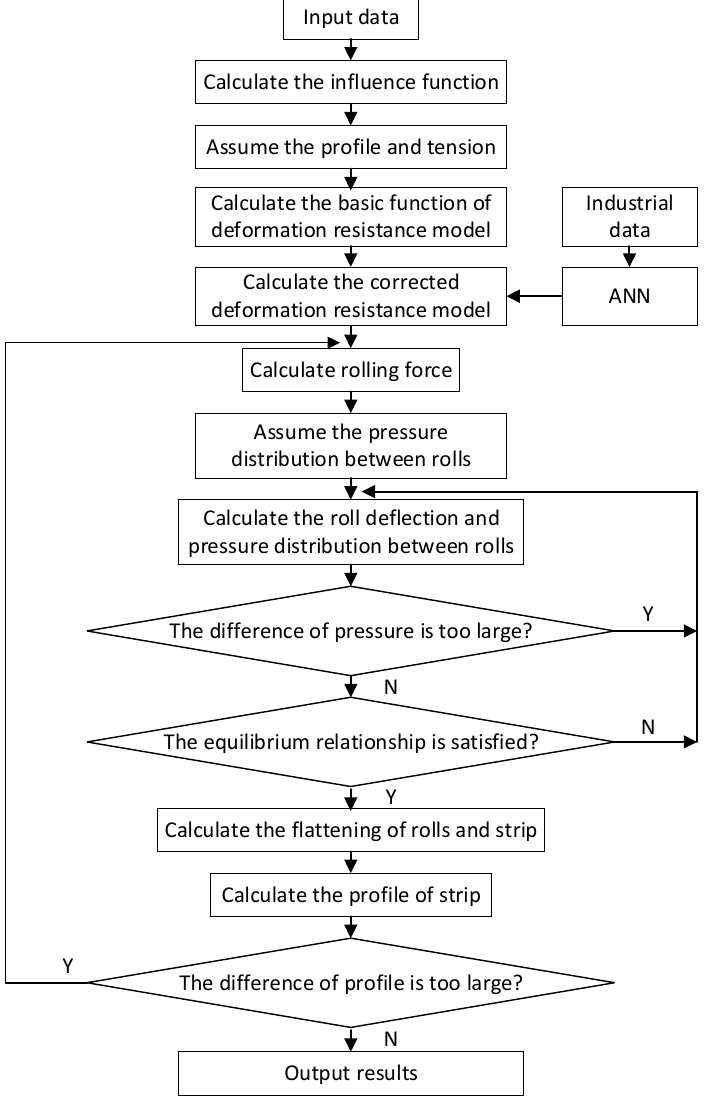
Figure 6. Flow diagram of elastic deformation calculation of rolls reproduced from [20].